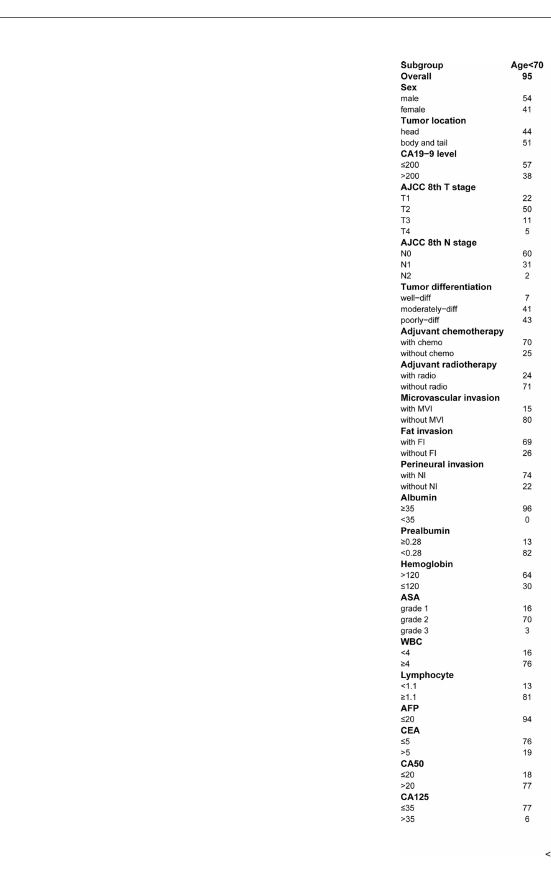
FIGURE 3 | Forest plot of overall survival hazard ratios (HRs) of major subgroups in the cohort after propensity score